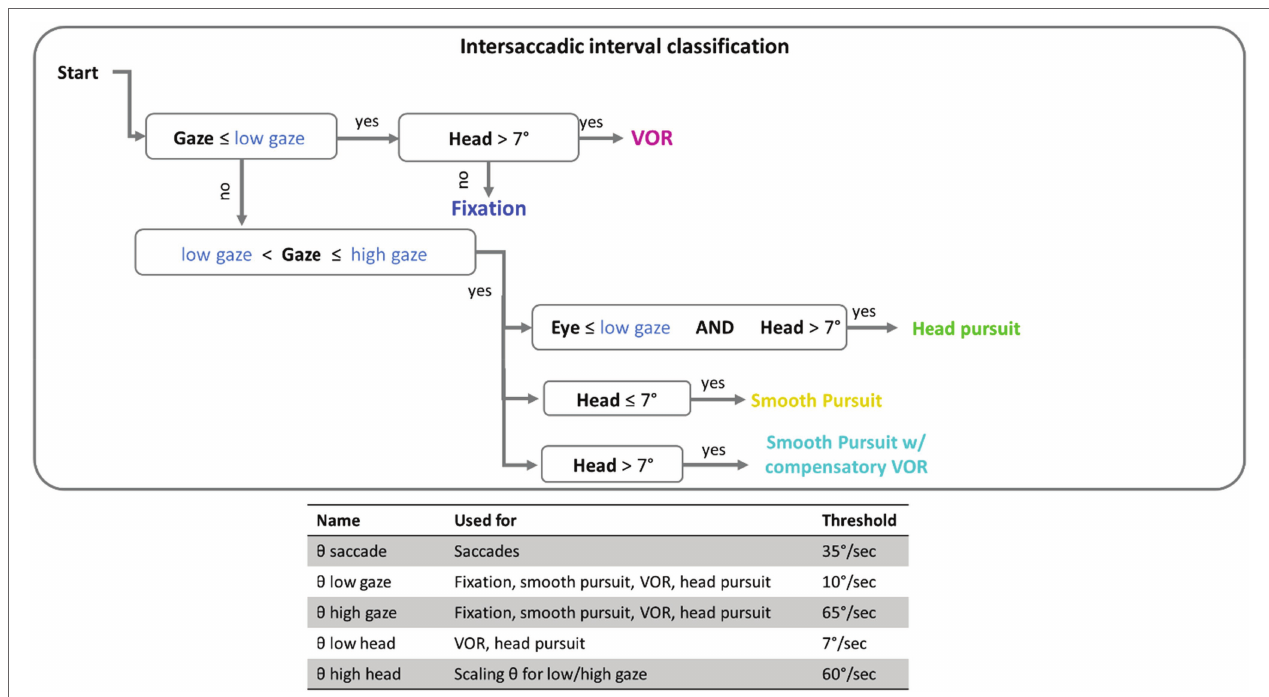
FIGURE 2 | Flow chart of the threshold classification. Intersaccadic intervals were divided into 100 ms windows for classification. Threshold in blue font are thresholds that are scaled by the current speed of the head. The table at the bottom contains the complete set of threshold values